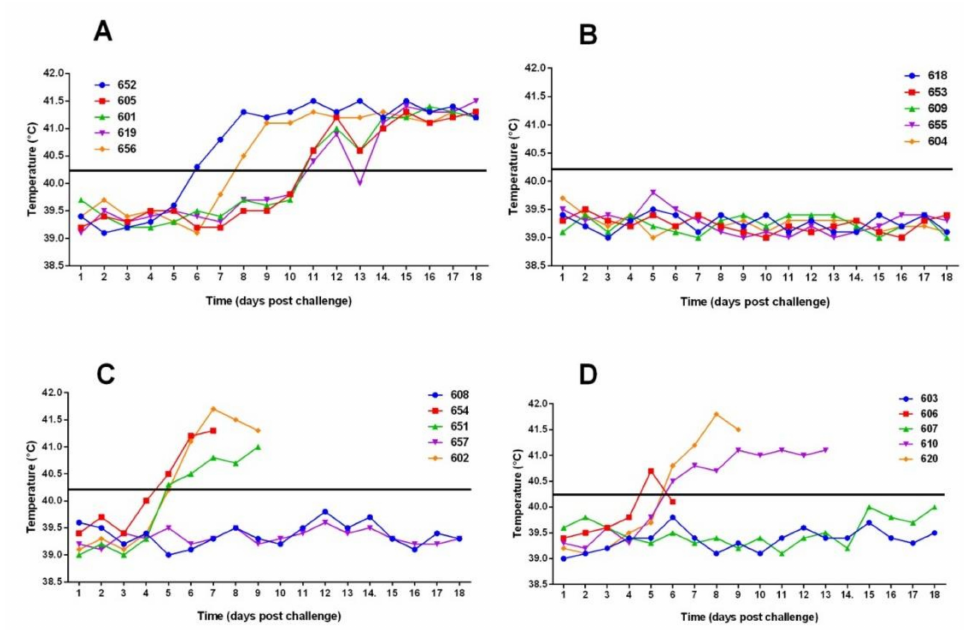
Figure 2. Rectal temperatures of animals post-challenge with “Margarita” strain of CSFV. ( A ) Group 1: control animals ( B ) Group 2: animals immunized once five days before challenge. ( C ) Group 3: animals immunized once three days before challenge. ( D ) Group 4: animals immunized once one day before challenge. The line represents the value of 40.2 ◦ C, temperatures above which were considered as a sign of